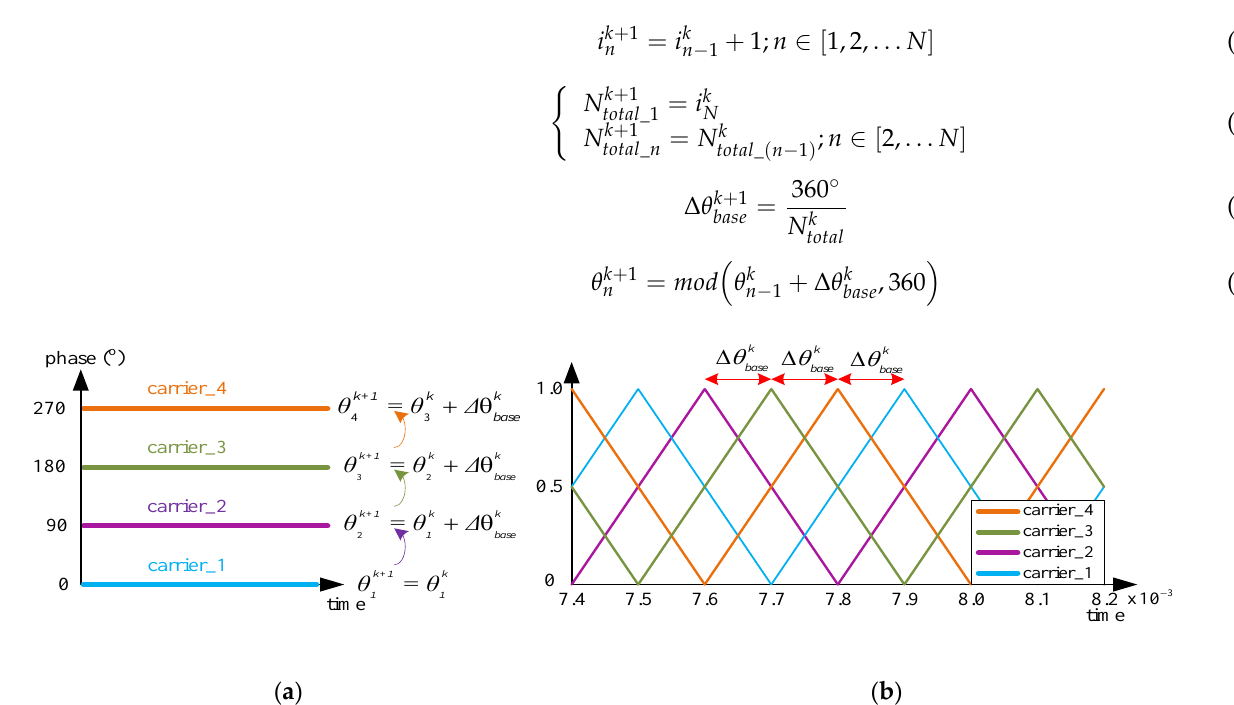
Figure 4. Proposed update rule of phase-angle of carriers in decentralized self-aligned phase-shift (PS) carriers (DSA-PSC) method, ( a ) update rule principle; ( b ) phase-shifted carriers.